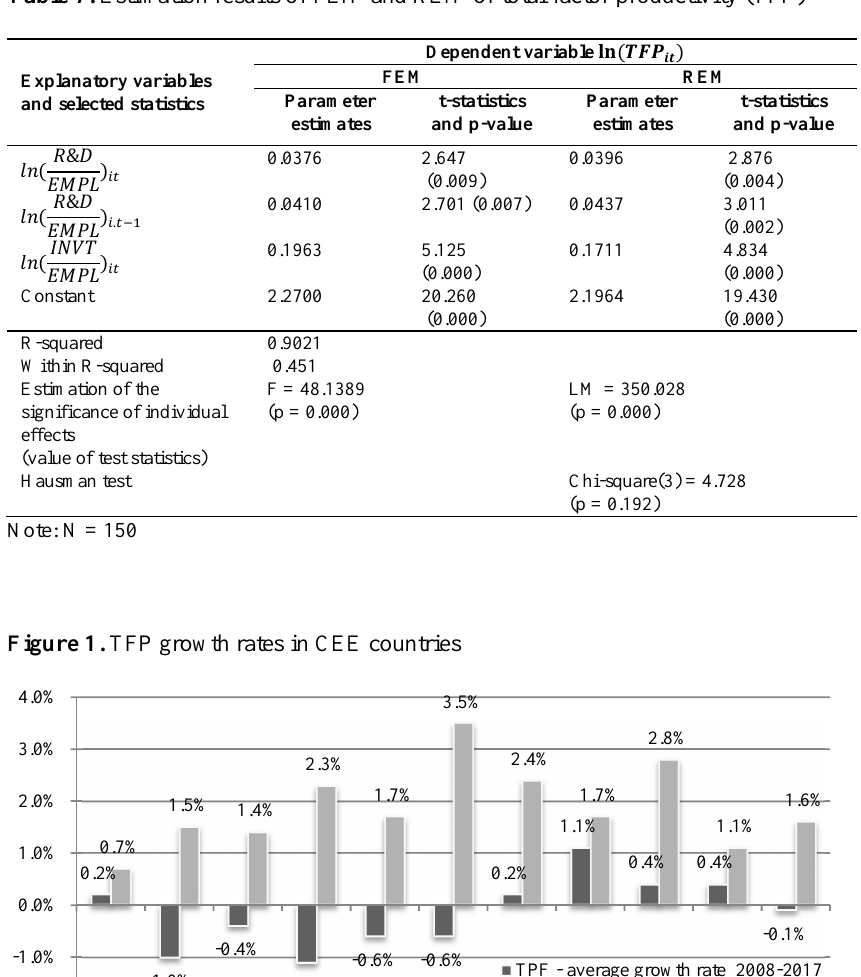
Table 7. Estimation results of FEM and REM of total factor productivity (TFP)